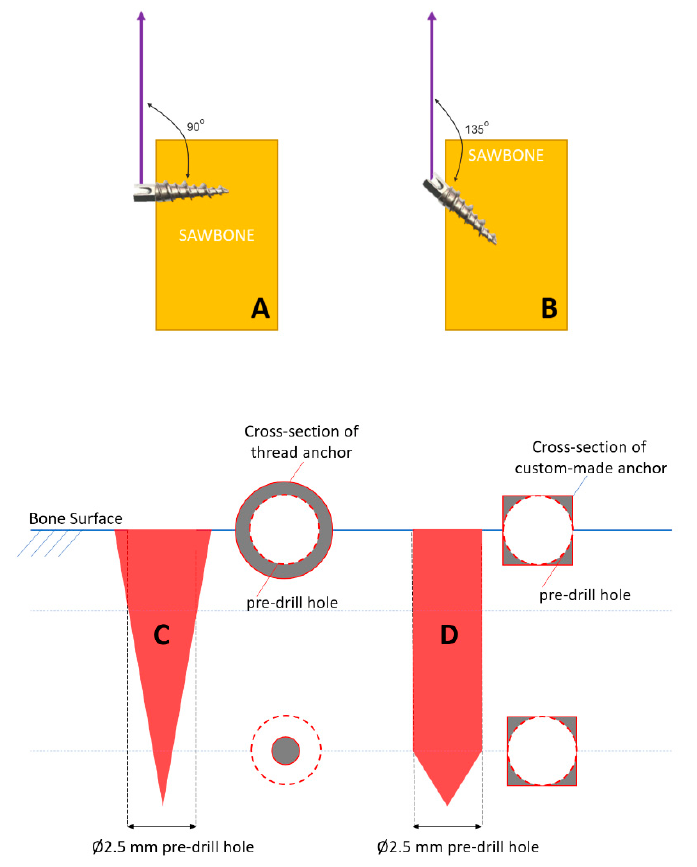
Figure 2. Loading was applied at 180° (parallel) to the bone surface. ( A ) Anchor inserted at 90° from the bone surface. ( B ) Anchor inserted at 135° from the bone surface. ( C ) Contact surface between threaded suture anchor and pre-drilled hole. ( D ) Contact surface between custom-made suture anchor and pre-drilled hole.